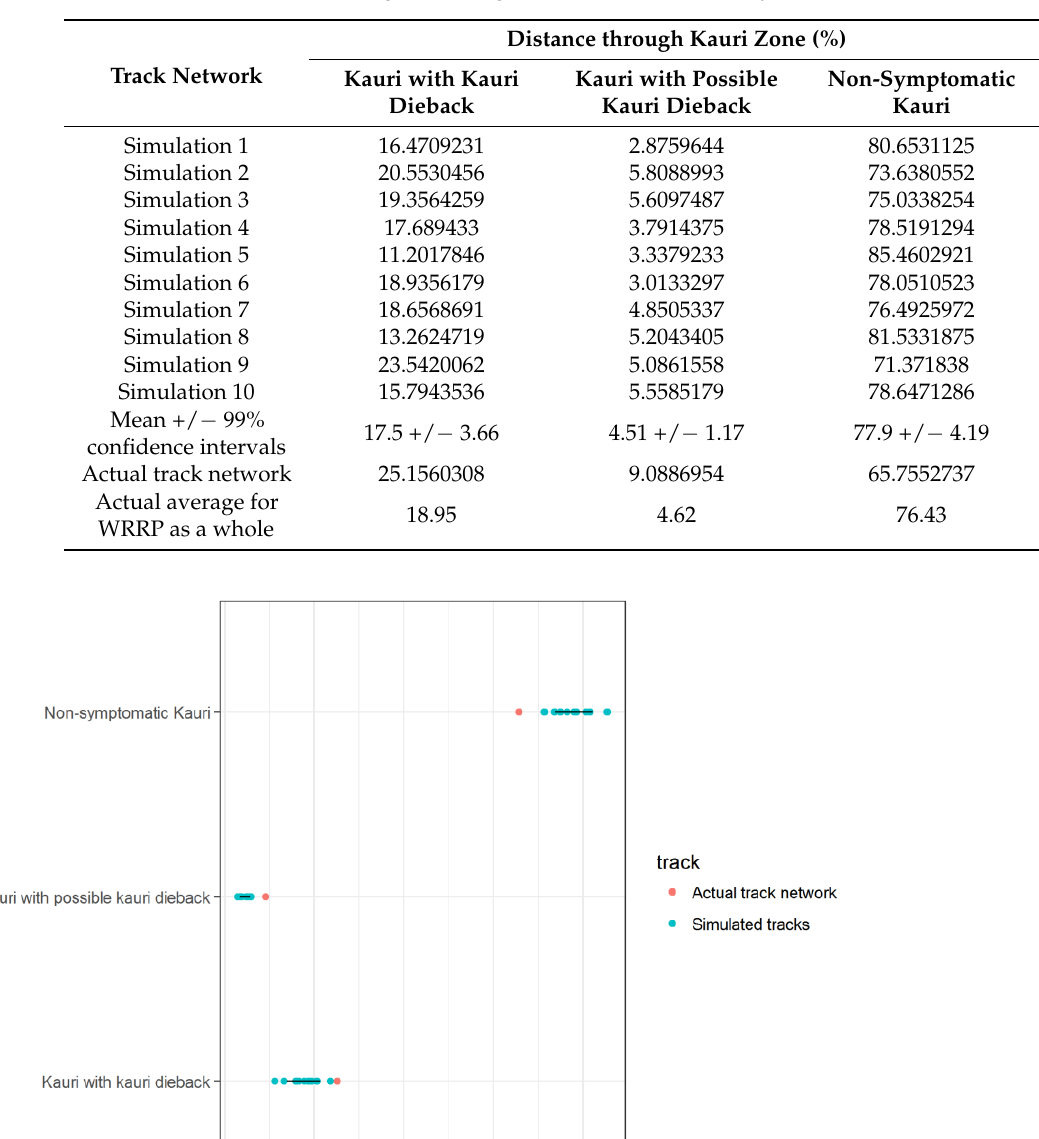
Table 3. Comparison of dieback along tracks (percentage) between actual data from this survey and simulated tracks of the same length showing that dieback is more likely to be nearer tracks.